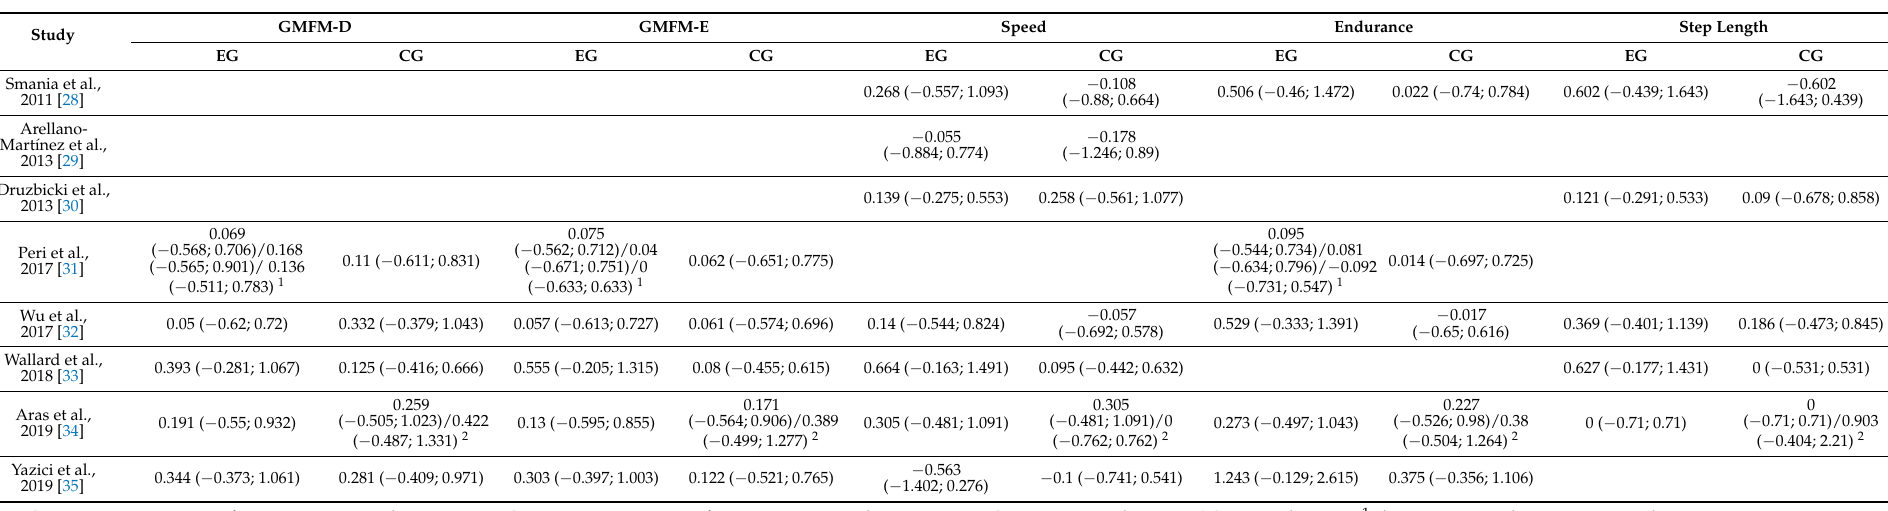
Table 3. Results of the outcome variables of the experimental groups (robot interventions) and control groups. (d pre-test-post-test